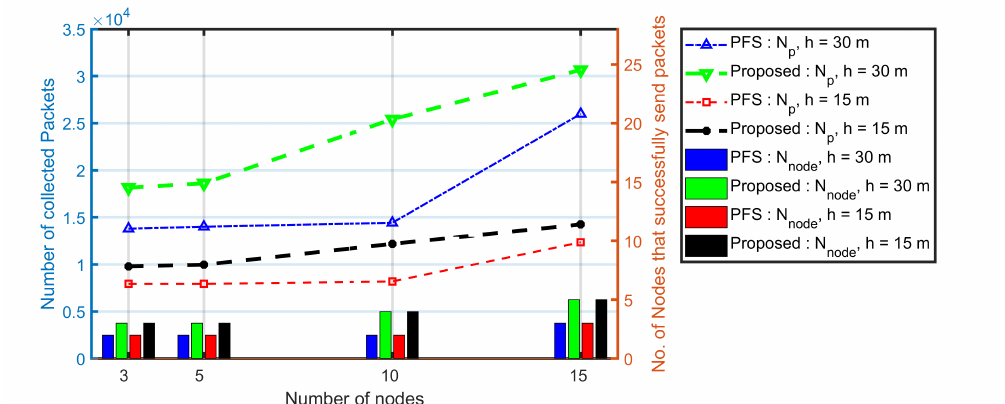
Figure 15. The impact of network size, and flying height over the system performance. In these experiments, the beacon interval is fixed at 2 s according to the simulation results in Figure 7.